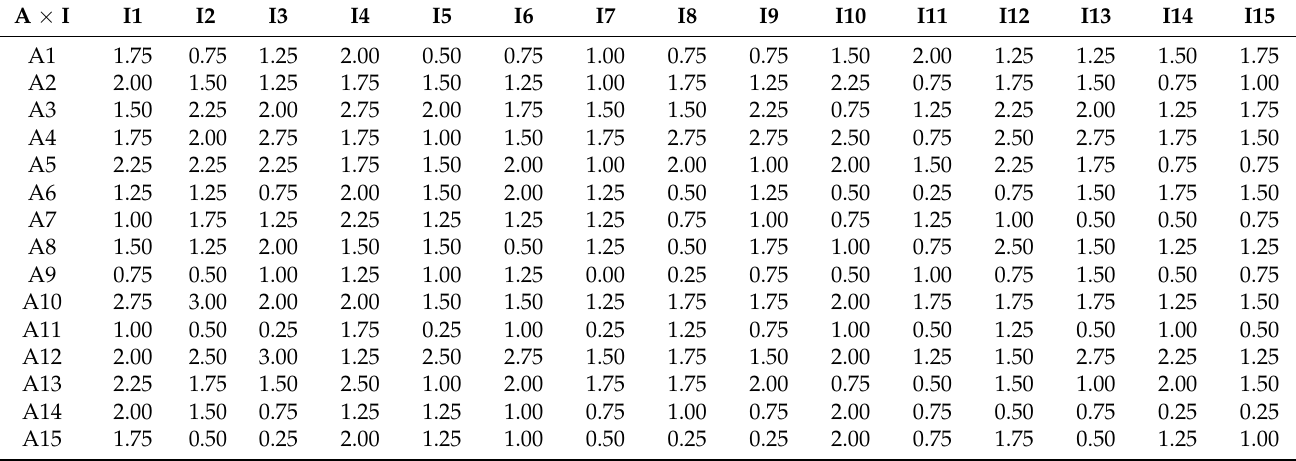
Table A2. The correlation matrix A × I of SCAIs and